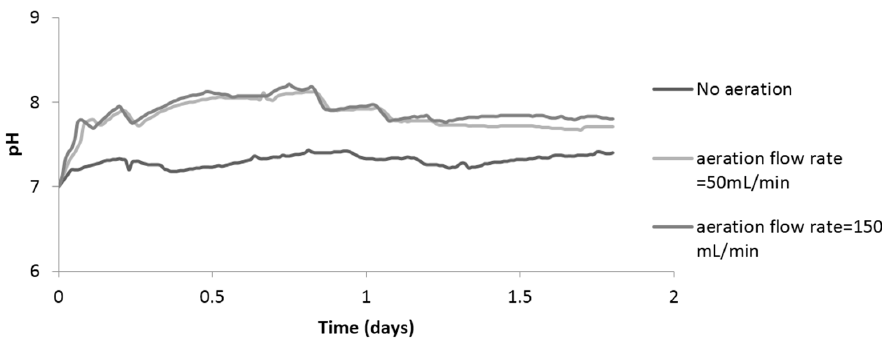
Figure 10. Impact of aeration flow rate on cathode pH.